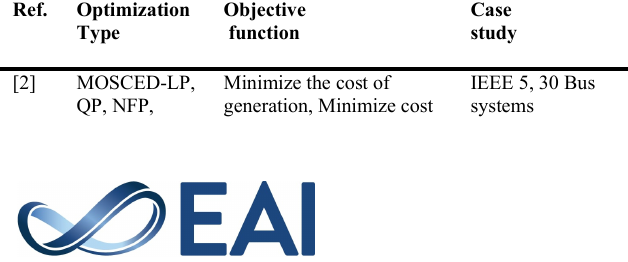
Table 1. Literature Survey/Review Summary